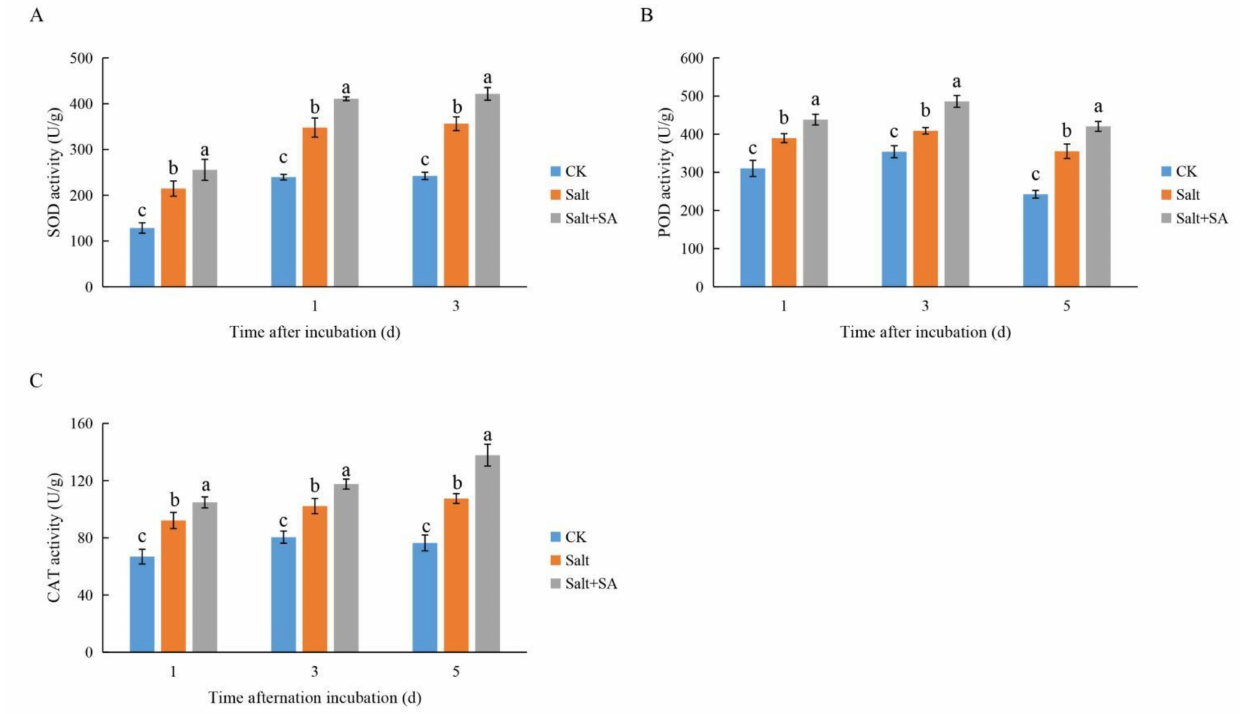
Figure 6. Effects of exogenous salicylic acid (SA) on superoxide dismutase (SOD), peroxidase